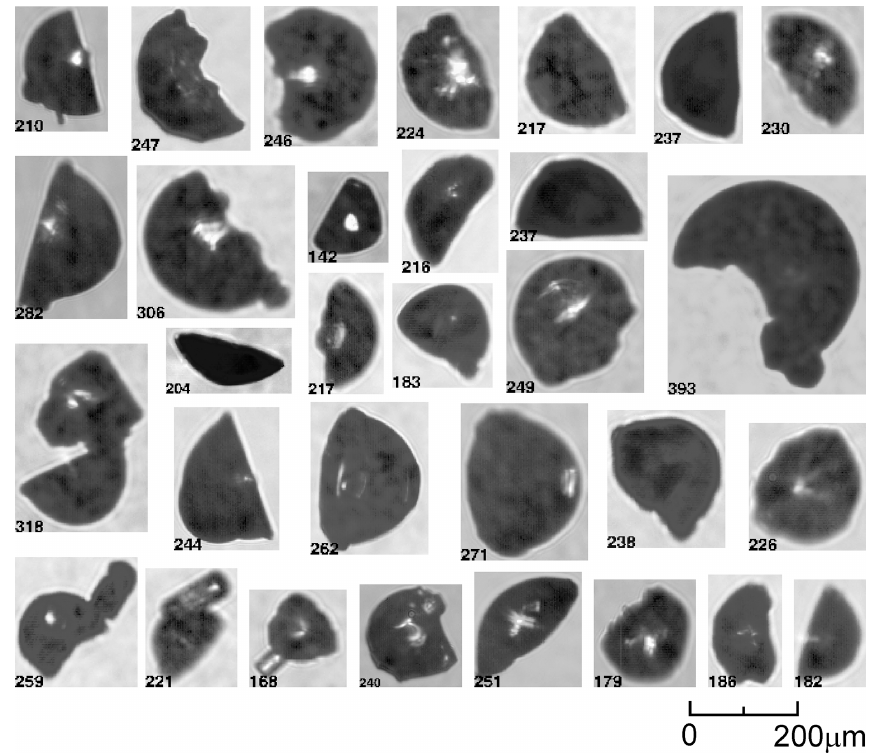
Figure 18. Images of fragmented frozen droplets collected in the SIP cloud regions indicated by grey areas in Figs. 5 and 13 at − 5 ◦ C < T a < − 1 ◦